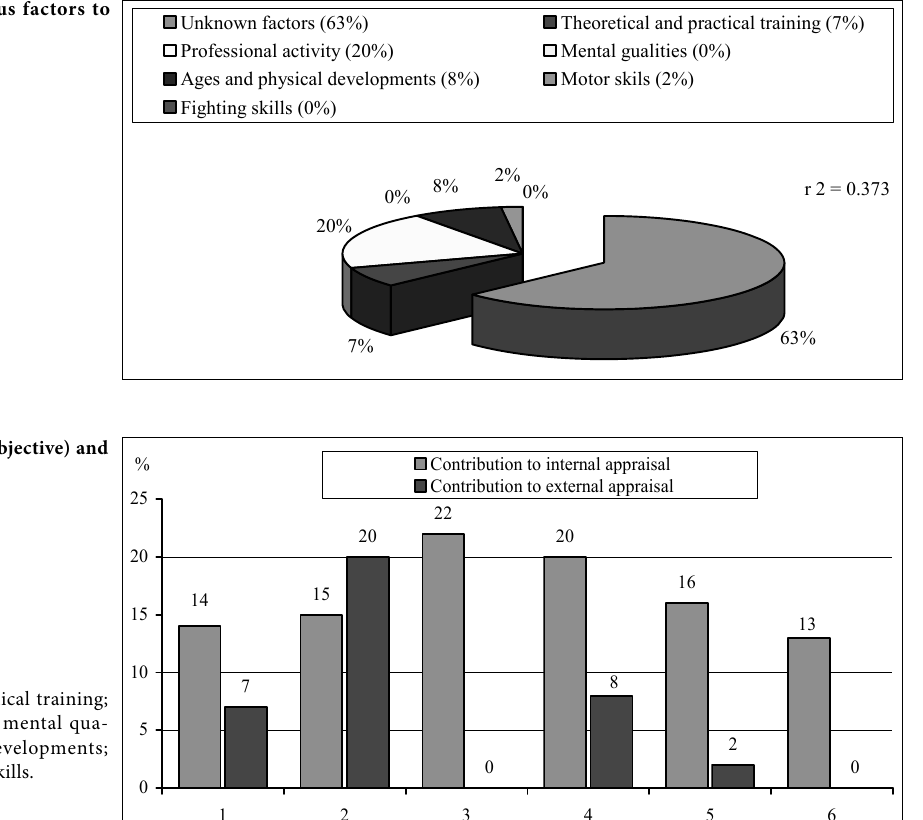
Fig. 3. Contribution of various factors to external